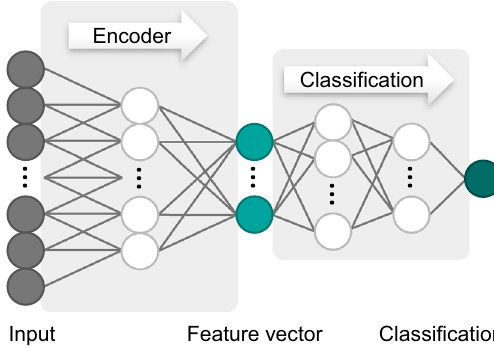
Fig. 5 Architectureofthecombinednetworkconsistingoftheencoder to extract feature vectors followed by the smaller classification network to identify events as SS or MS less relevant for 0 νββ decay searches and are more affected by noise.